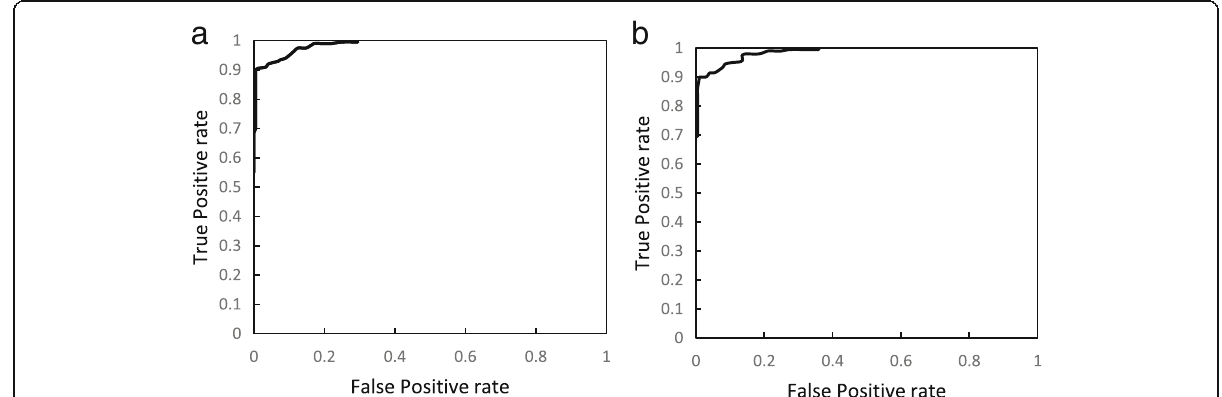
Fig. 7 ROC curve with different number of keywords. a Receiver operating characteristic curve with 200 keywords. b Receiver operating characteristic curve with 300 keywords